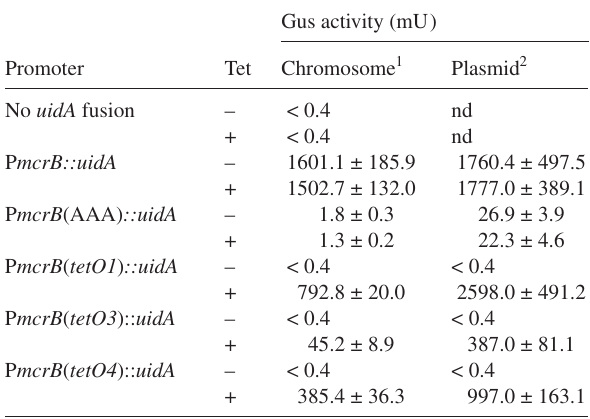
Table 3. Gus activity of P mcrB::uidA fusions and derivatives.